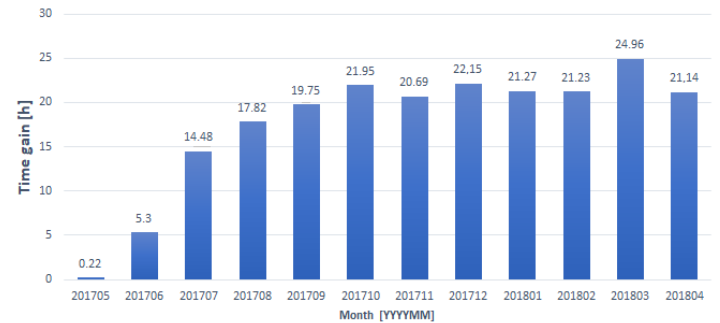
Figure 13. An estimated gain of the time per month, in hours, for Risk max =